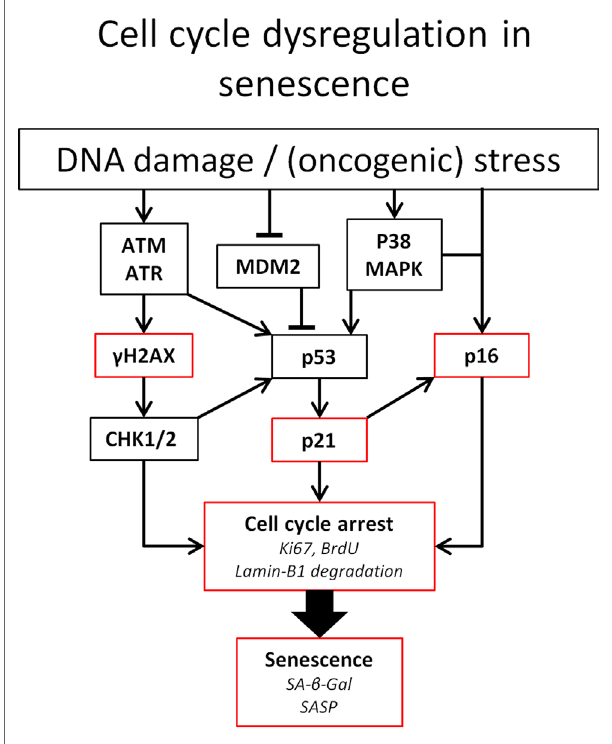
FIGURE 1 | Pathways involved in cell cycle arrest. Established means to identify senescent cells are indicated in red. Ataxia telangiectasia mutated (ATM) and ATM-Rad3-related (ATR) kinases play a central role in DNA damage detection and response. Both proteins rapidly phosphorylase histone 2AX. Furthermore, ATM and ATR can both lead to the phosphorylation of the tumor suppressor p53(pSer15) upon DNA damage. Furthermore, ATM phosphorylates the checkpoint kinases Chk1 and Chk2. Chk2 directly phosphorylates p53 at pSer20, leading to the expression of the CKI p21. Phosphorylation of p21 inhibits CDK, leading to the hypophosphorylation of retinoblastoma tumor suppressor (Rb). This enables Rb to bind to E2F, inhibiting cell cycle progression. Likewise, p53 activity can be increased by p38 MAPK activity, induced by ROS, or by binding of p14 ARF to murine double minute 2 (MDM2) preventing degradation of p53 (Elledge and Zhou, 2000; Hirao et al., 2002; Fischer et al., 2016). In addition to p53, the accumulation of the tumor suppressor p16 Ink4a also leads to cell cycle arrest via the inhibition of CDK4/CDK6 and subsequent hypophosphorylation of Rb (Moonen et al., 2018). Abbreviations: BrdU,